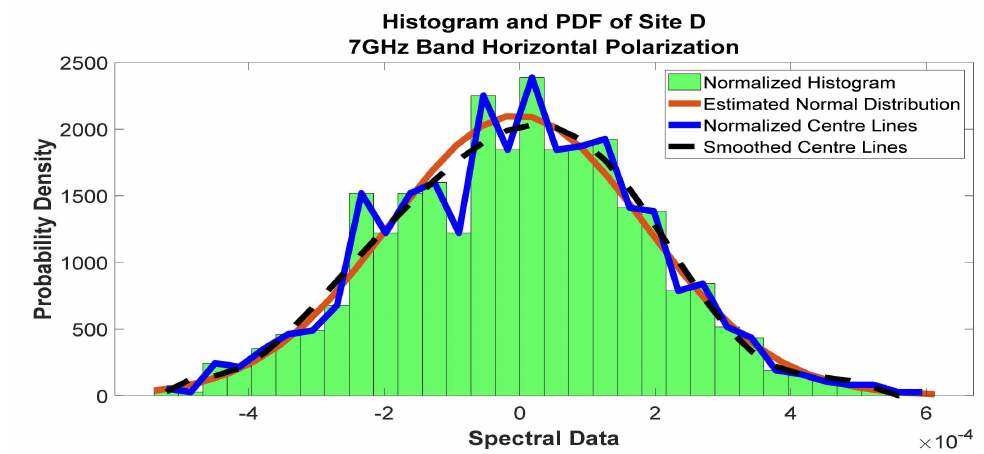
Figure 22. Histogram and PDF of the frequency scan for site D at 7 GHz horizontal polarization.